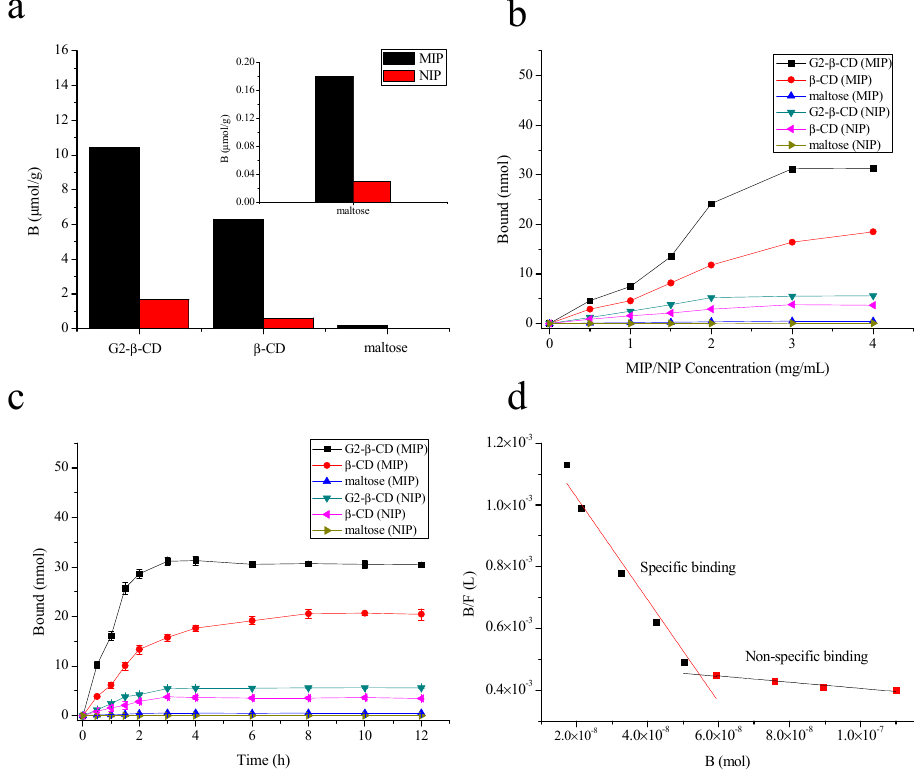
Figure 4. Binding properties of 6- O - α - D -maltosyl- β -cyclodextrin (G2- β -CD), β -cyclodextrin ( β -CD), and maltose on MIP and molecularly non-imprinted polymer (NIP). ( a ) Binding selectivity; ( b ) equilibrium binding experiments; ( c ) binding isotherm; and ( d ) binding kinetics.